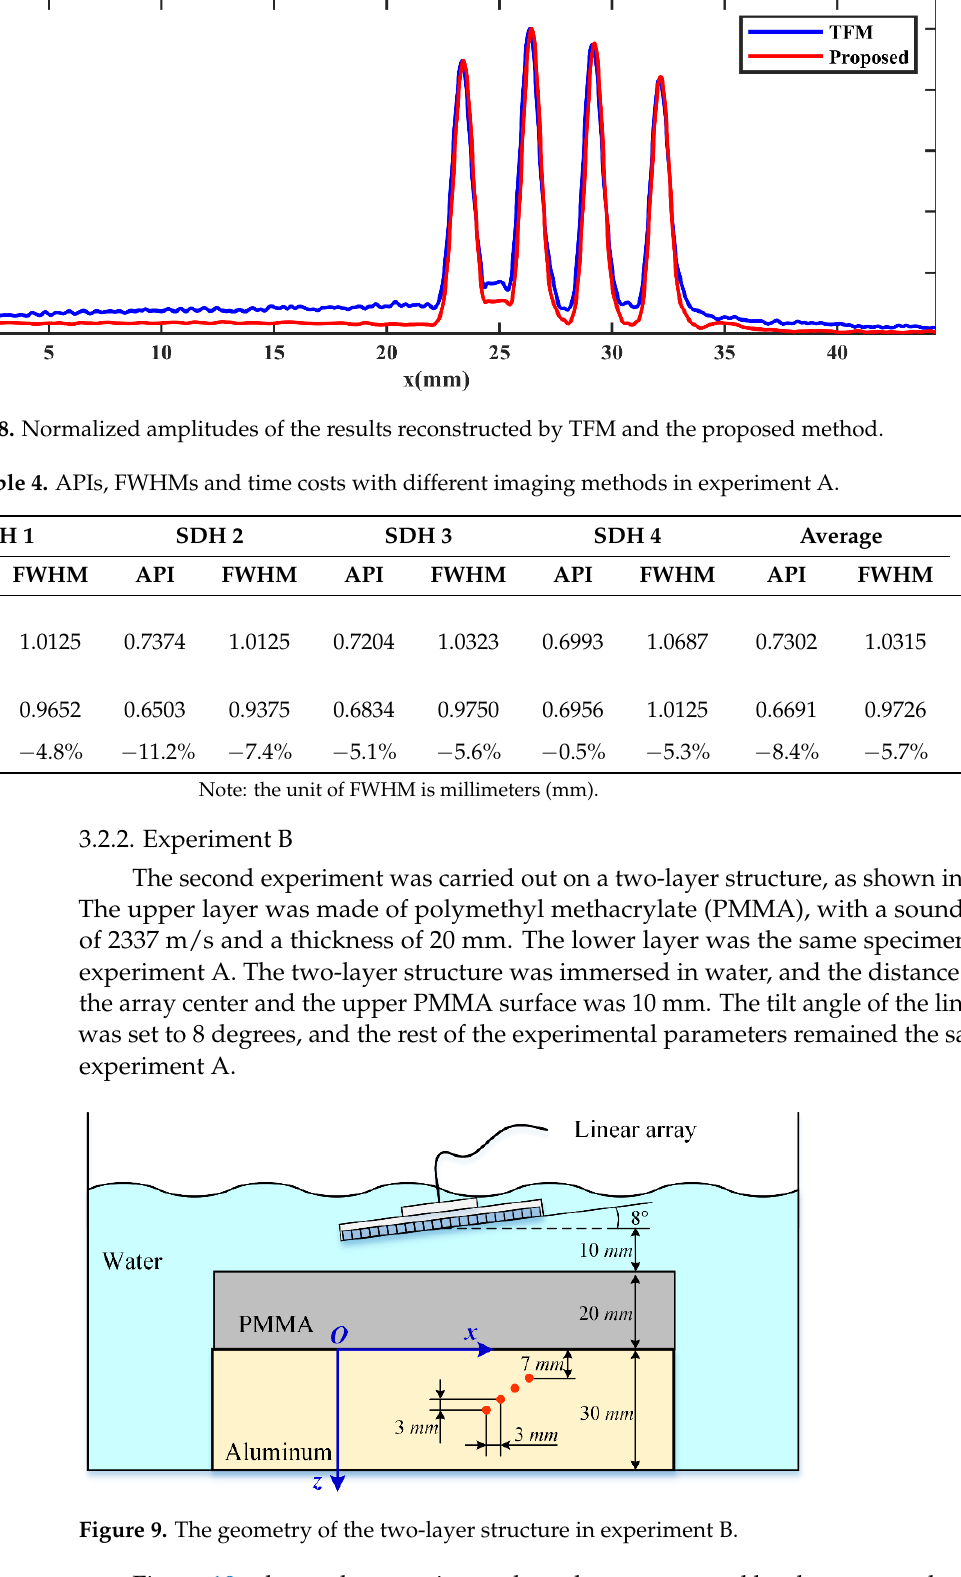
Table 4. APIs, FWHMs and time costs with different imaging methods in experiment A.